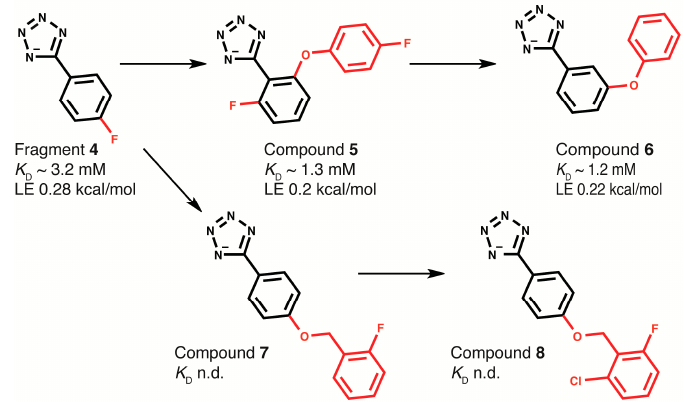
Figure 8. Schematic representation of optimization of fragment 4 . The red labeled groups were added during fragment-to-hit optimization. LE: Ligand efficiency ( ∆ G /[number of heavy atoms]), n.d.: not determined.